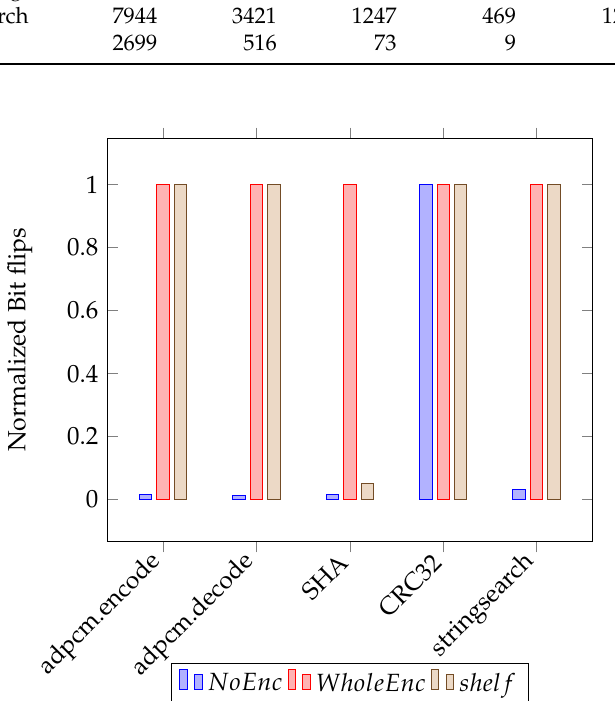
Figure 18. Bit flips normalized by whole